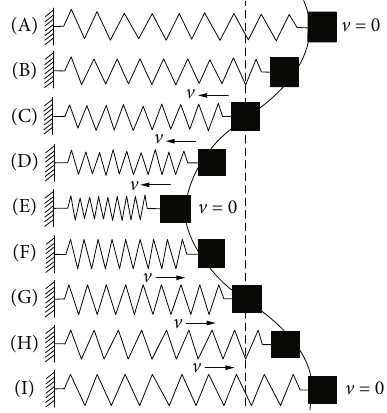
Figure 2: Simple harmonic vibration.